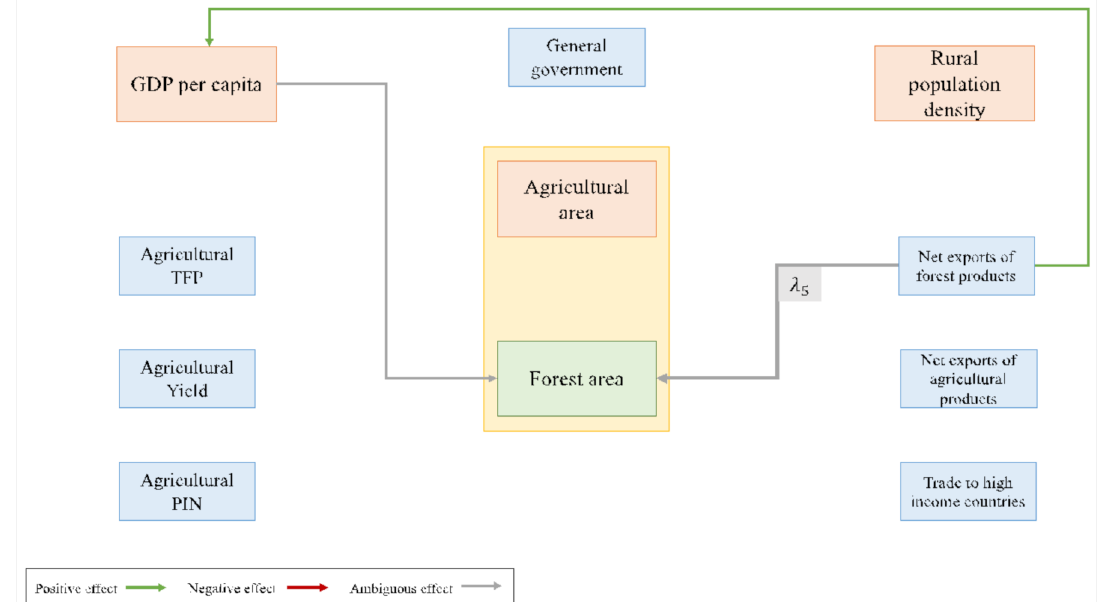
Figure A6. Estimating indirect effects of “Net exports of forest products”